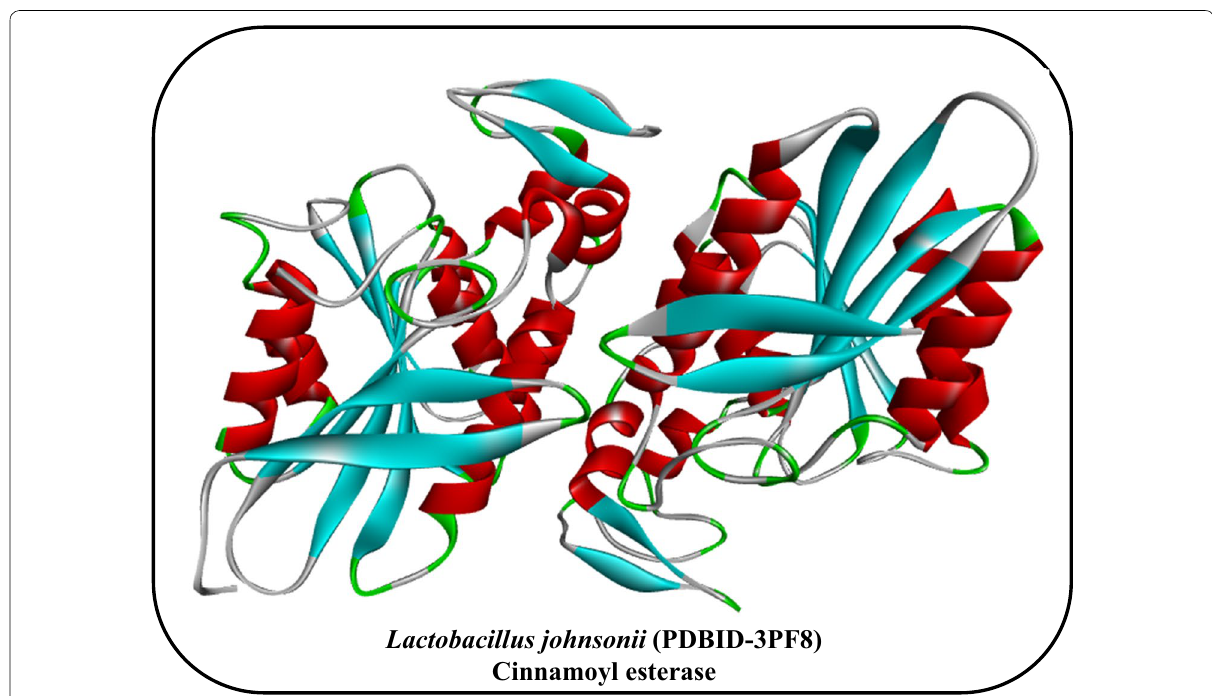
Fig. 4 The protein secondary structure of Lactobacillus johnsonii cinnamoyl esterase (carbohydrate esterase class-I) (PDB ID:3PF8) (Lai et al. 2011), where alpha-helices (red), beta strands (blue) and coils (gray). (Image was developed using Discovery Studio Visualizer ®